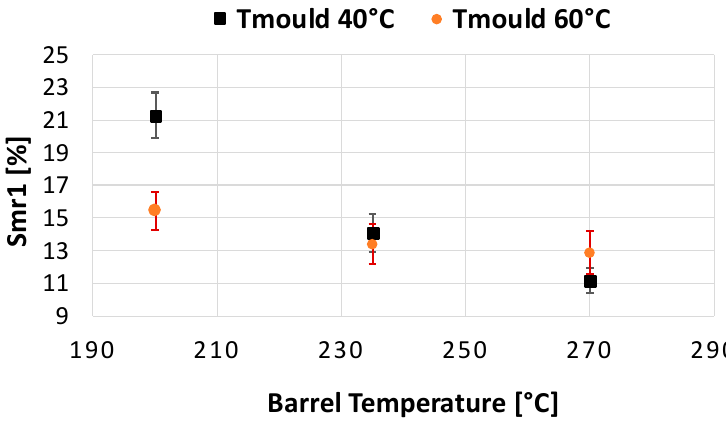
Figure 6. Two factor interaction of mould temperature (T m ) and barrel temperature (T b ) on Smr1.